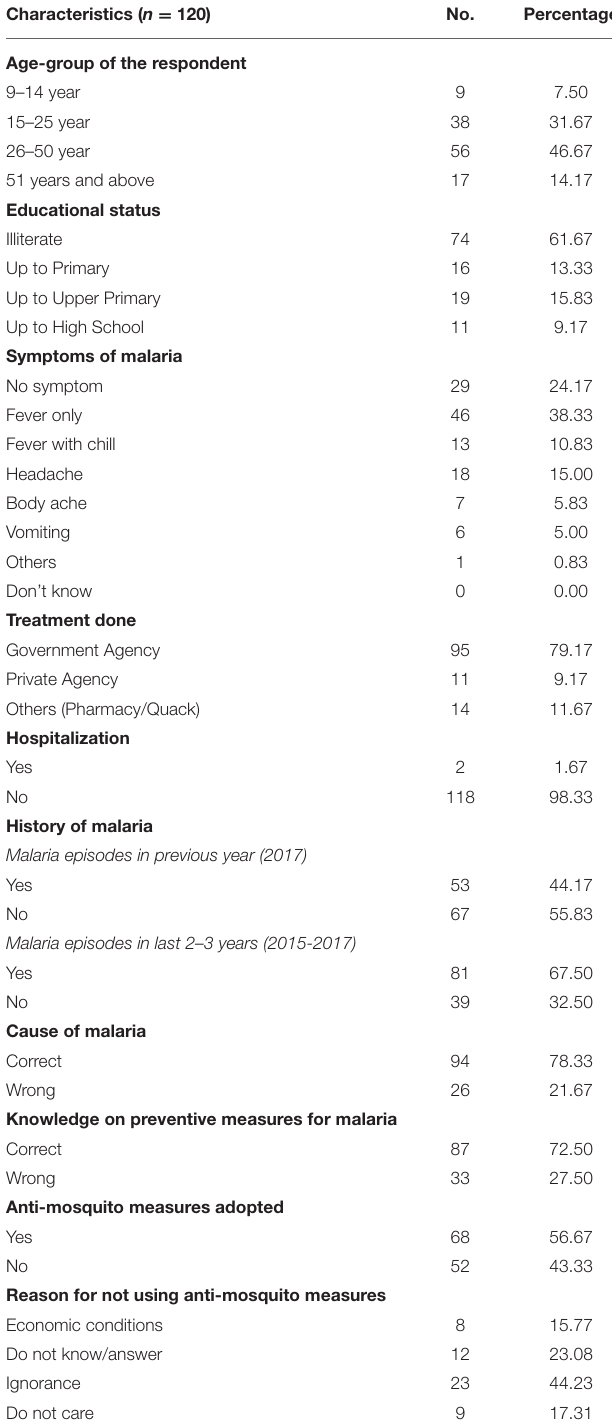
TABLE 3 | Knowledge, Attitude and Practices related to malaria among respondents ( n = 120) in the Dolonibasti sub-center, 2018. Characteristics ( n =